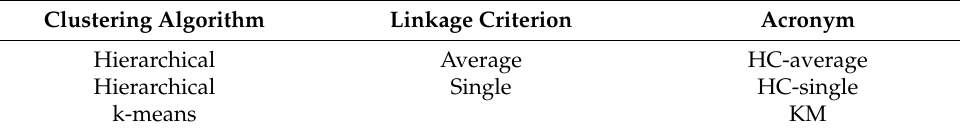
Table 2. Clustering algorithms adopted to group nodes within each